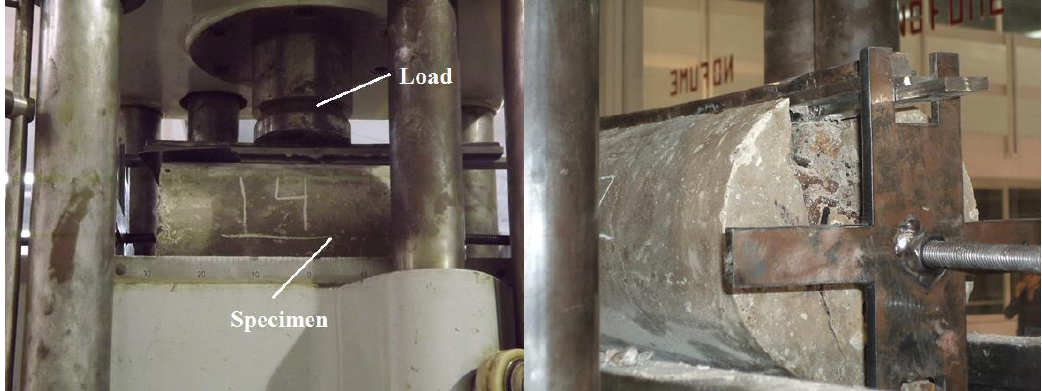
Figure 10. Splitting tensile test.